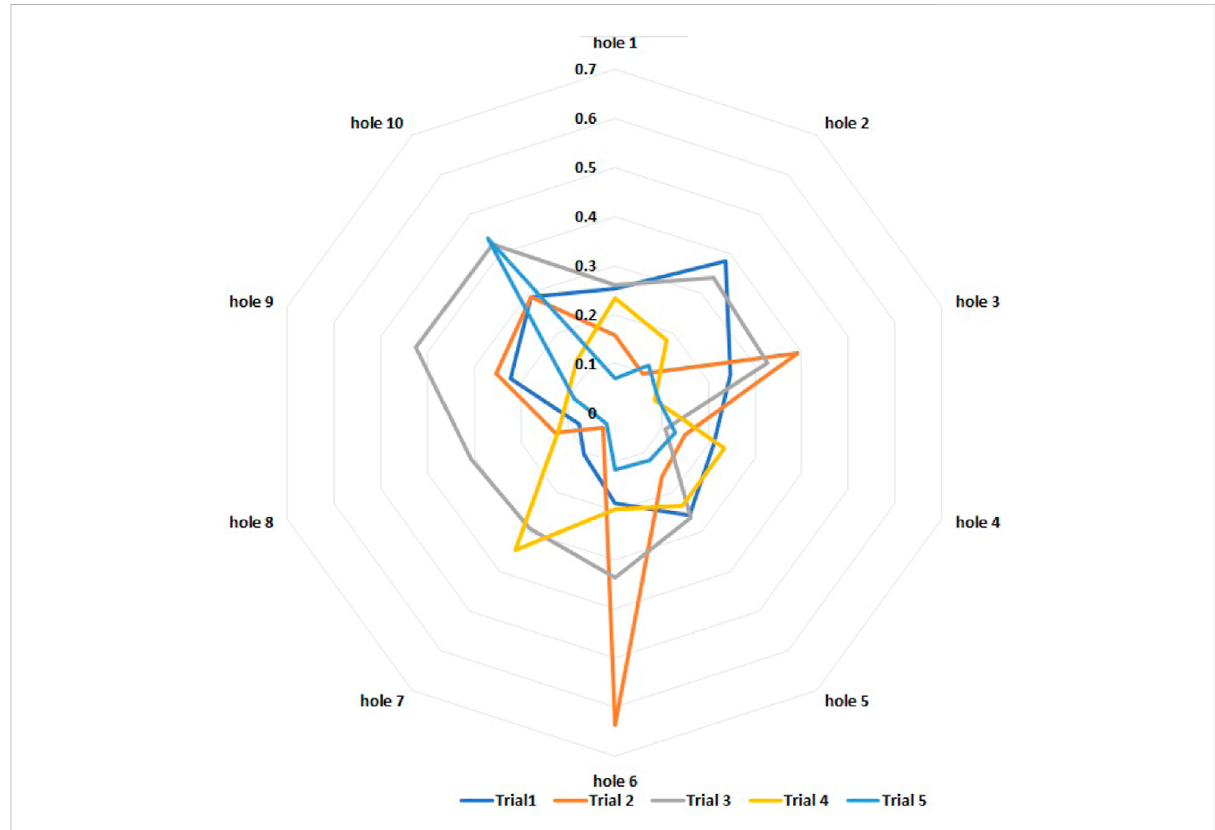
FIGURE 6 Task 1: estimation errors of the positions of each hole during fi ve trials (one color per trial, errors in meters).